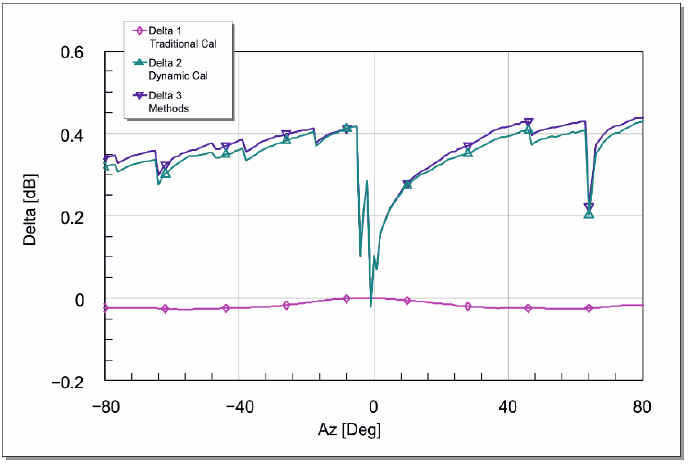
Figure 11. Difference of AUT radiation patterns for traditional (static) and dynamic calibrations at frequency f = 3.75 GHz.